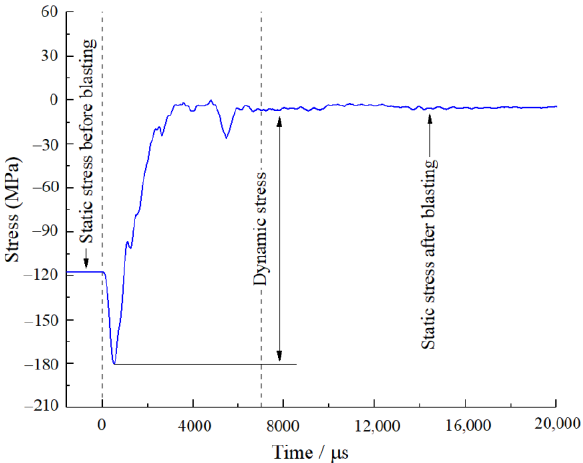
Figure 6. Typical stress – time curve recorded by measuring circle.